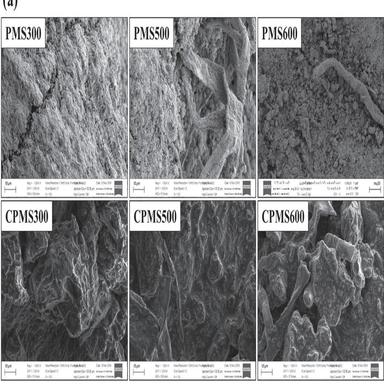
FE-SEM images of (a) PMS biochar (b) P and PS biochar.